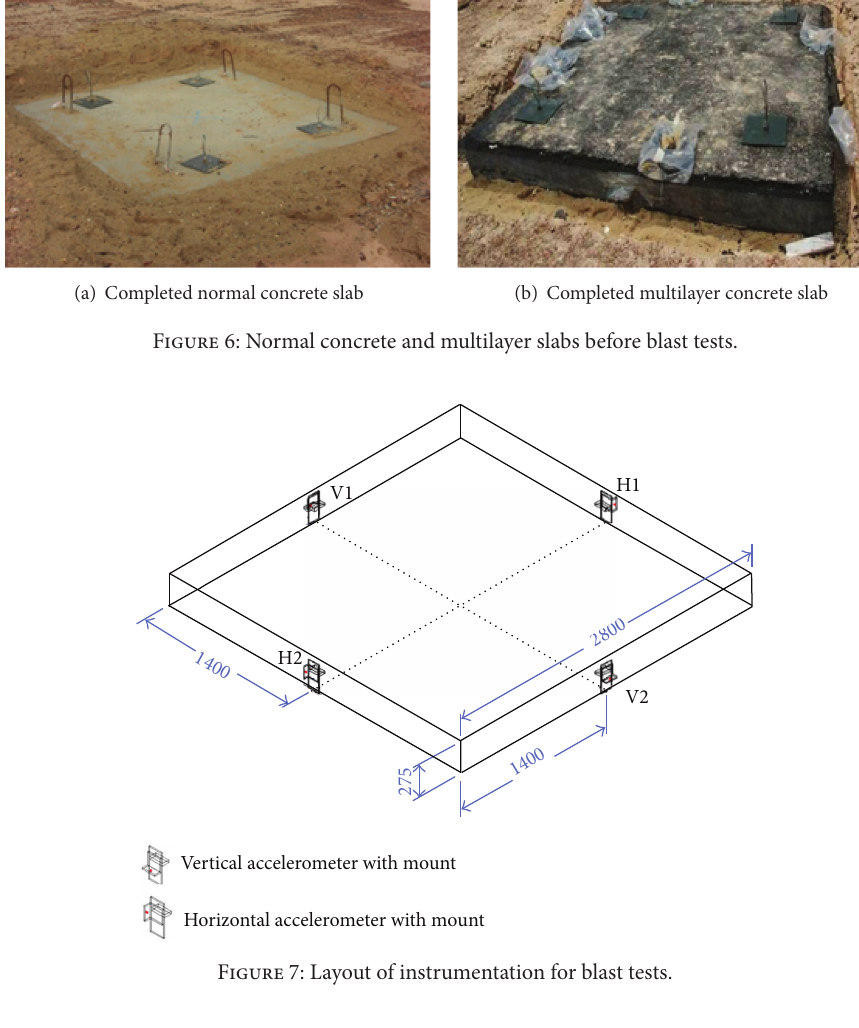
Table 2: Properties of materials cast for field blast test.